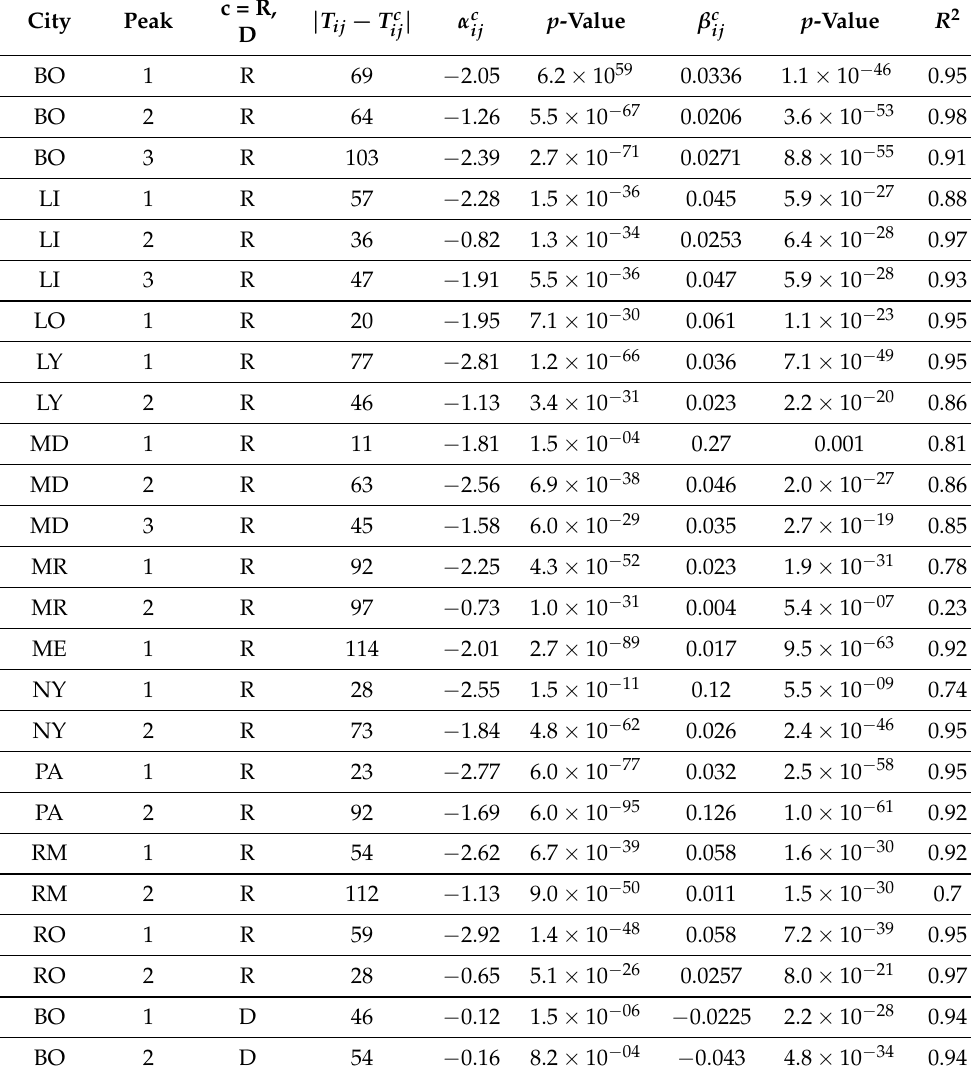
Table 3. Estimation in the total regression